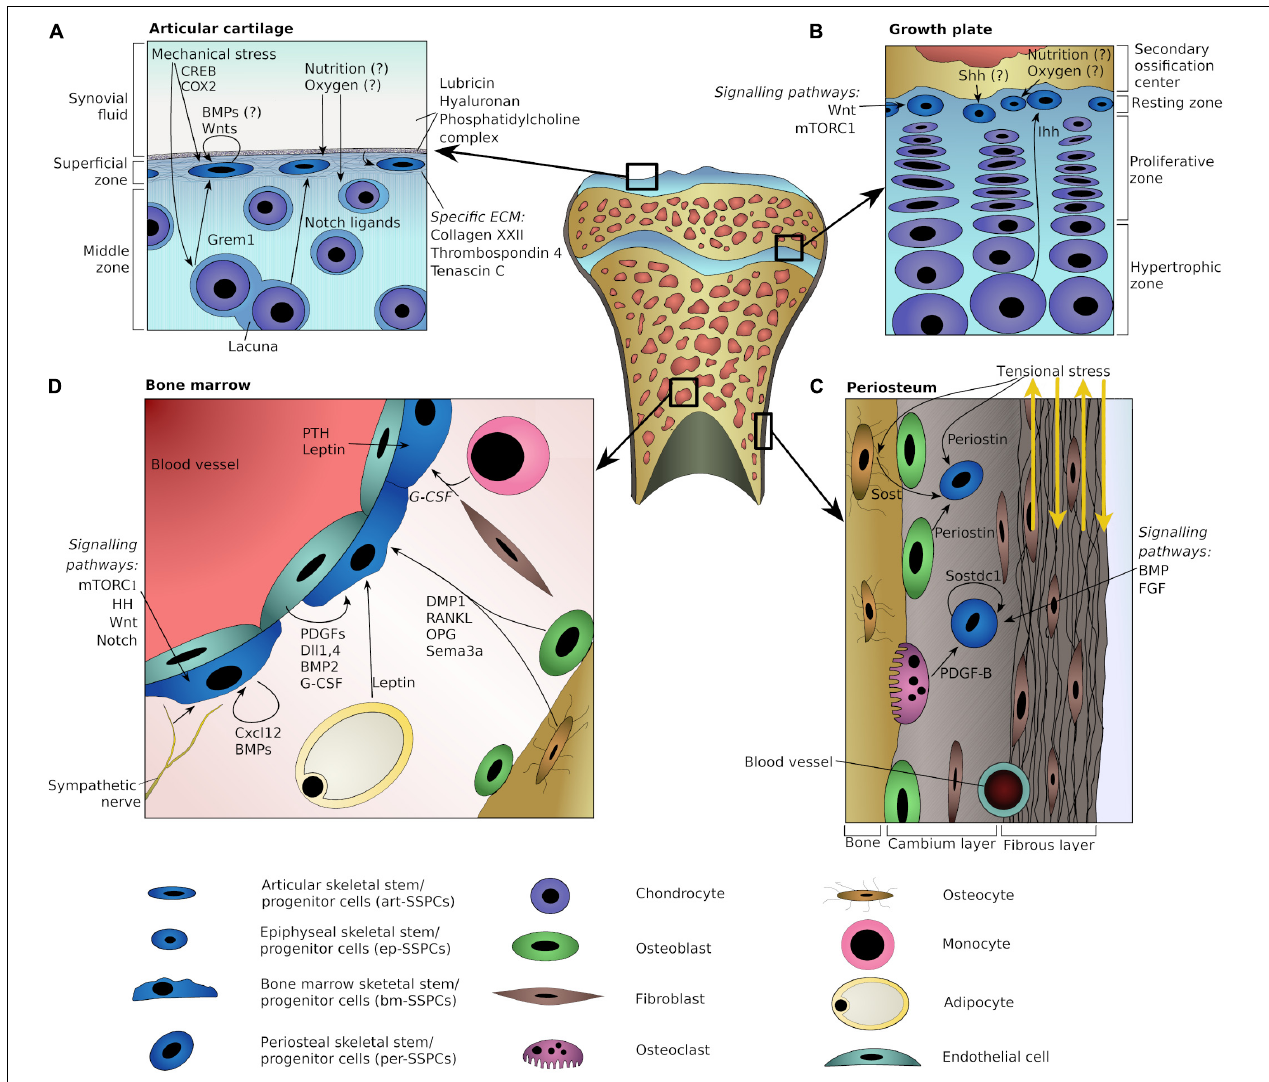
FIGURE 1 | Schematic representation of plausible niche components at various skeletal locations. Potential niche components are shown for articular cartilage (A) , epiphyseal growth plate (B) , periosteum (C) , and adult bone marrow (D) . Arrows indicate directions of interactions or point toward specific cells. Question marks indicate potential players with the lack of strong direct